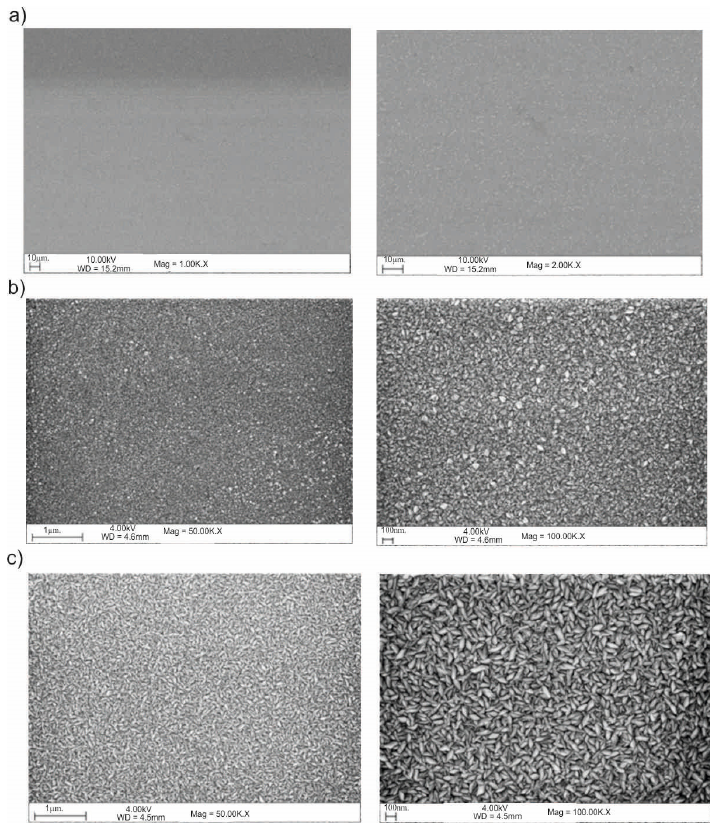
Figure 17. SEM of the sample surface morphology for the electropolished samples: ( a ) initial state, ( b ) 500_200 °C, ( c ) 1500_200 °C.